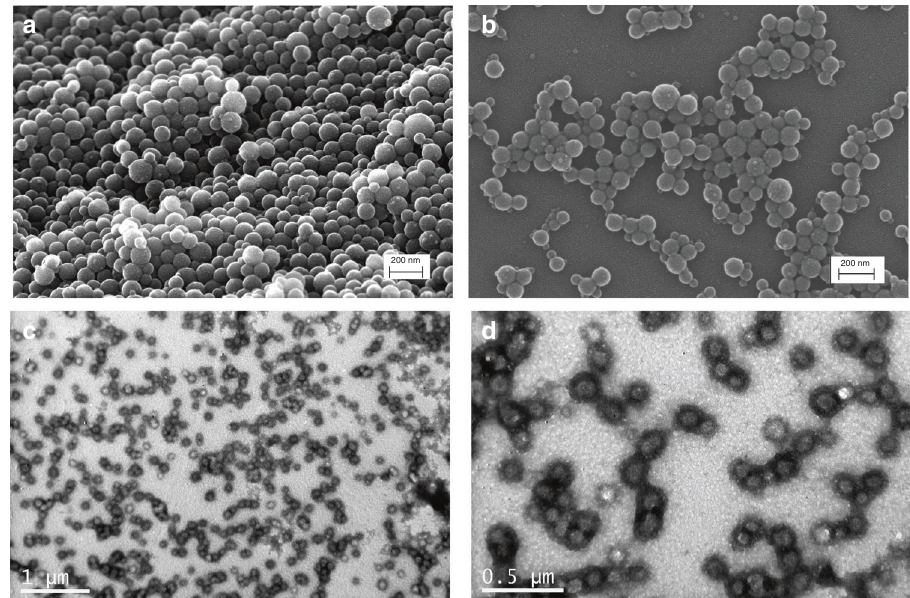
Fig. 4 Morphological characterization of BSA-polymer bioconjugates. SEM micrographs of BSA-PS uniform spherical assemblies synthesized using molar feed ratio a [M n ]/[I o ] = 5000/1 and b 2000/1 respectively. c , d TEM micrographs of BSA-PDMAEMA spherical assemblies synthesized using molar